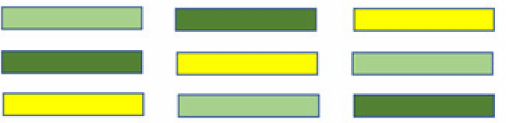
Figure 2. Randomised block design of pots in Cyprus 2019. Light Green—Xynisteri XK. Dark Green—Xynisteri XM. Yellow—Sauvignon Blanc. n = 10 vines per block.